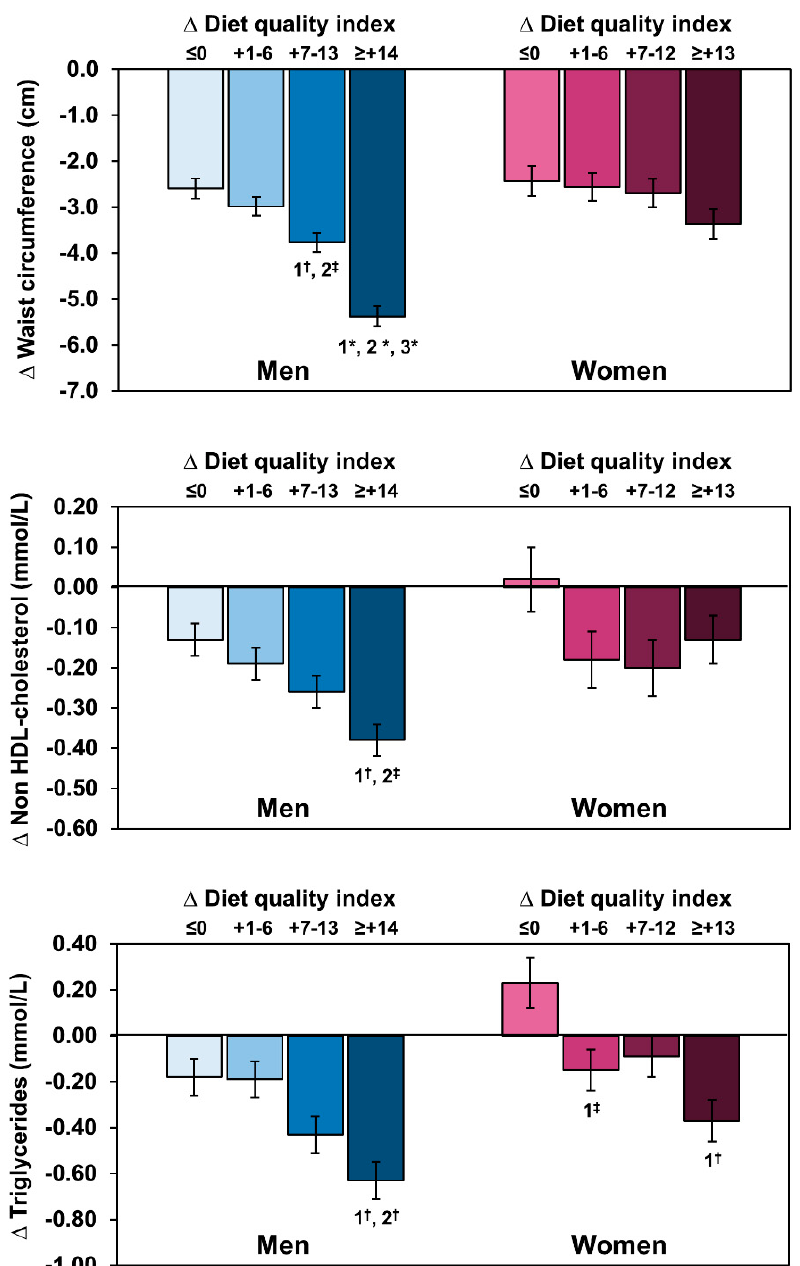
Figure 4. Changes in waist circumference, non-HDL cholesterol, and triglycerides according to quartiles of changes in diet quality index in response to the 3-month lifestyle modification program. Data represent least-squares means ± standard error to the mean adjusted for the baseline diet quality index. ‡ p < 0.05; † p < 0.001; * p < 0.0001.